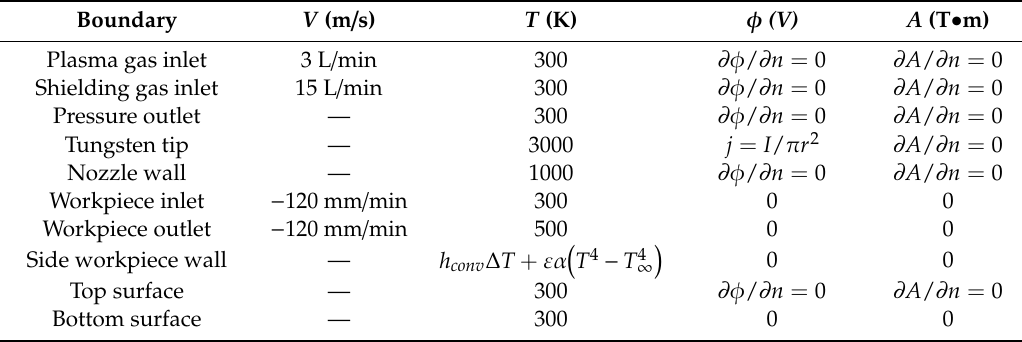
Table 1. Boundary conditions of the unified model.